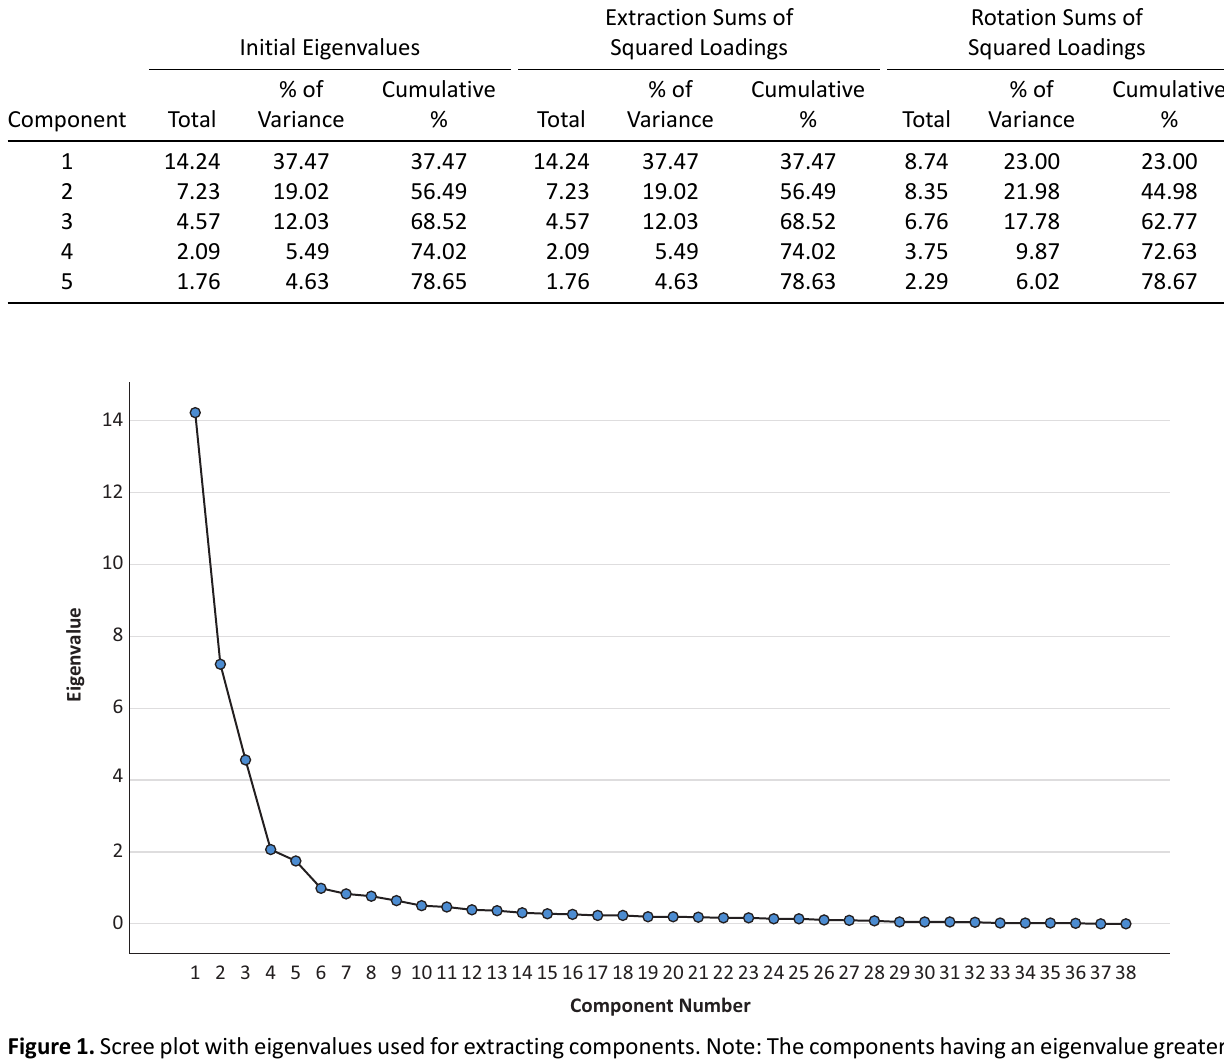
Figure 1. Scree plot with eigenvalues used for extracting components. Note: The components having an eigenvalue greater than one are retained as principal